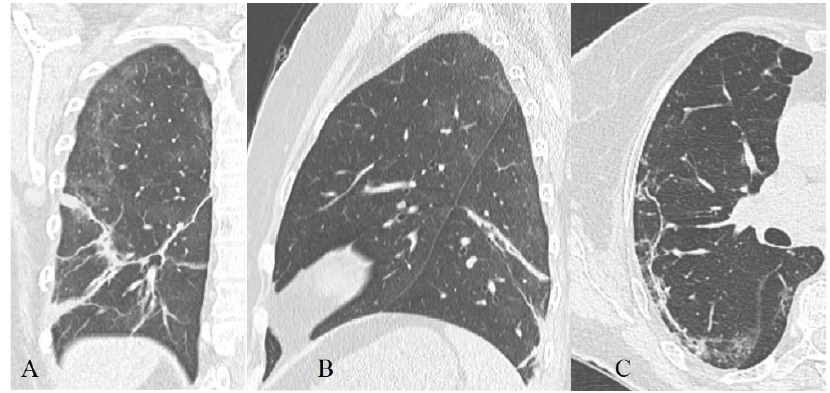
Figure 7. Linear ( A , B ) and curvilinear ( C ) pleuroparenchymal bands. RC and pleuroparenchymal bands were registered in 61% and 58% of cases in recov- ered patients, respectively, and in 59% and 47% — in the dead. The recovered patients had a greater contribution of these changes to the overall CT picture (on average, 16.8 ± 17% vs. 11.3 ± 11.1% and 13 ± 14.1% vs. 7.6 ± 10%).